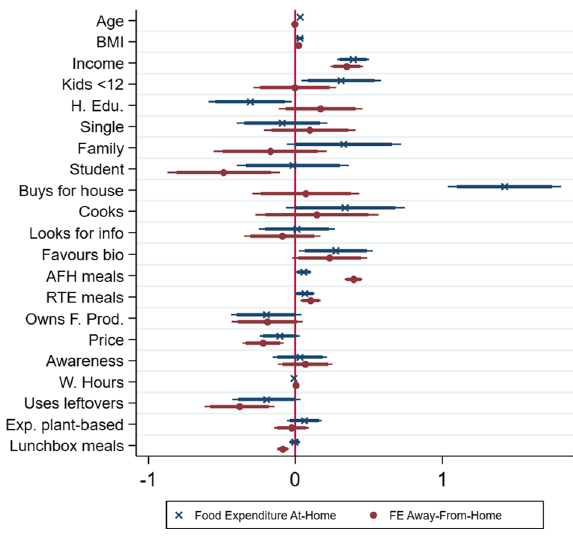
Fig. 5 Coefficients of covariates for food expenditure (Eqs. 2,